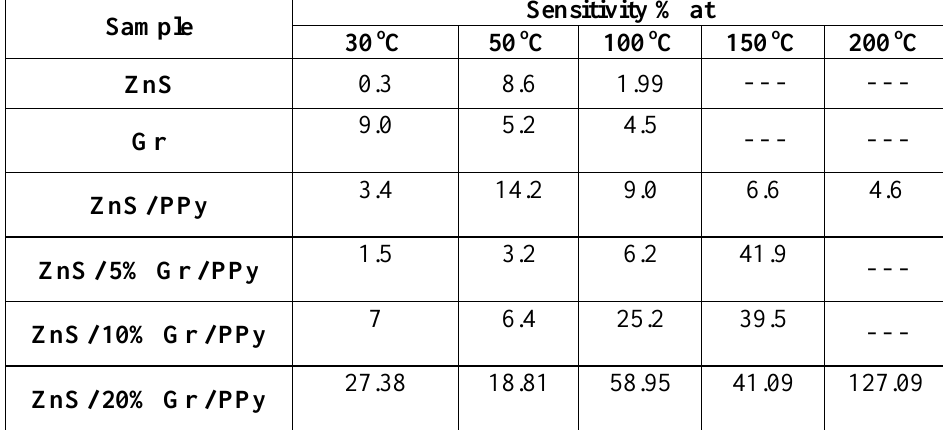
Fig.9: The variation of resistance with time for ZnS/20% Gr/PPy at different operating temperatures against NO gas. 2 Table 3: Sensitivity% for ZnS / Gr / PPy with different volume ratios (5, 10, 20)% of Gr against NO 2